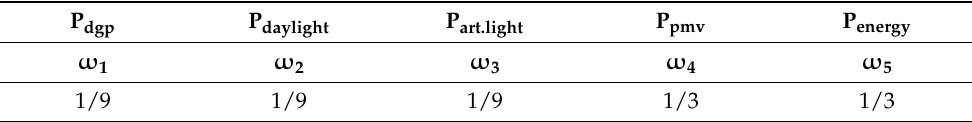
Table 4. Weighting fractions used in penalty function for near-optimal control (CtrlPen). P